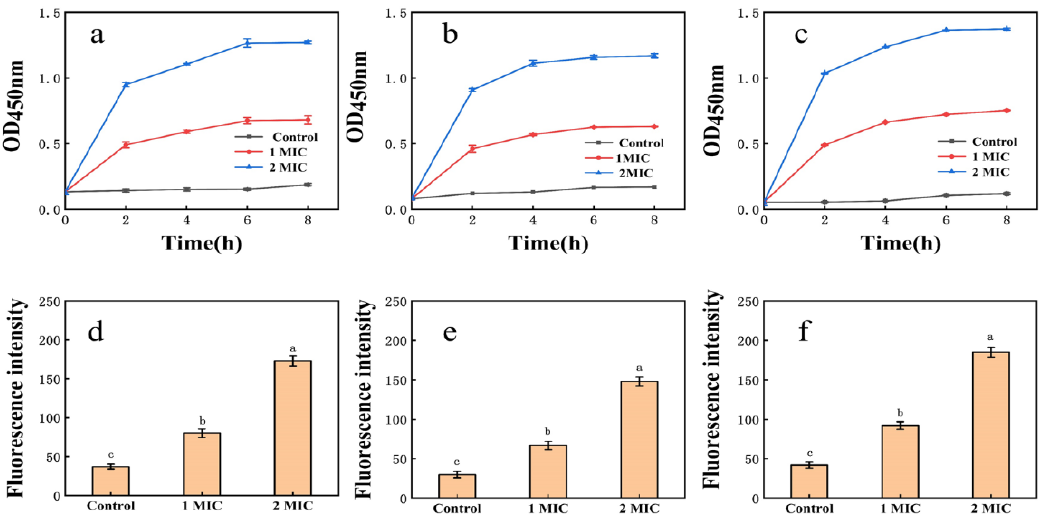
Figure 3. ( a ): Effect of EPS on the membrane permeability of E. coli ; ( b ): effect of EPS on the membrane permeability of S.